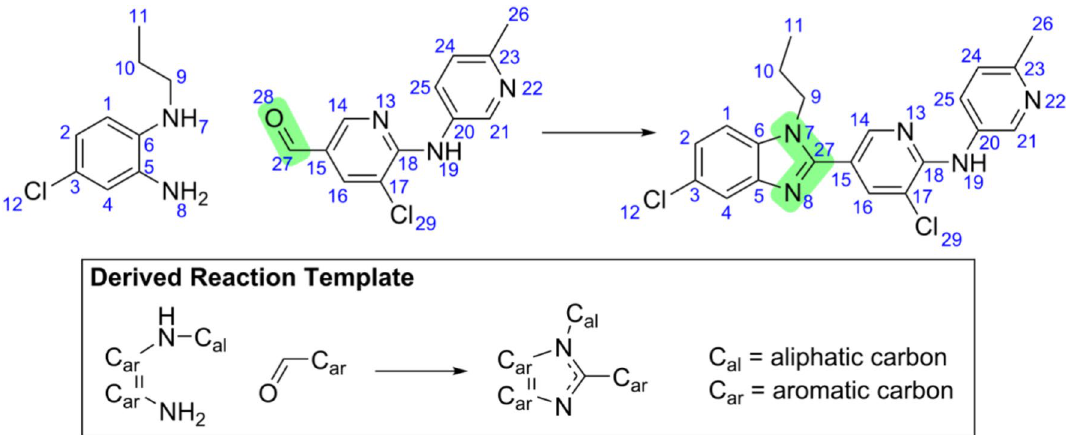
Fig. 4 Example of a reaction and its corresponding reaction template. The reaction is centered in the green-highlighted areas (27,28), (7,27), and (8,27). The corresponding template includes the reaction center and nearby functional groups. Reproduced with permission from the work of Jin et al.